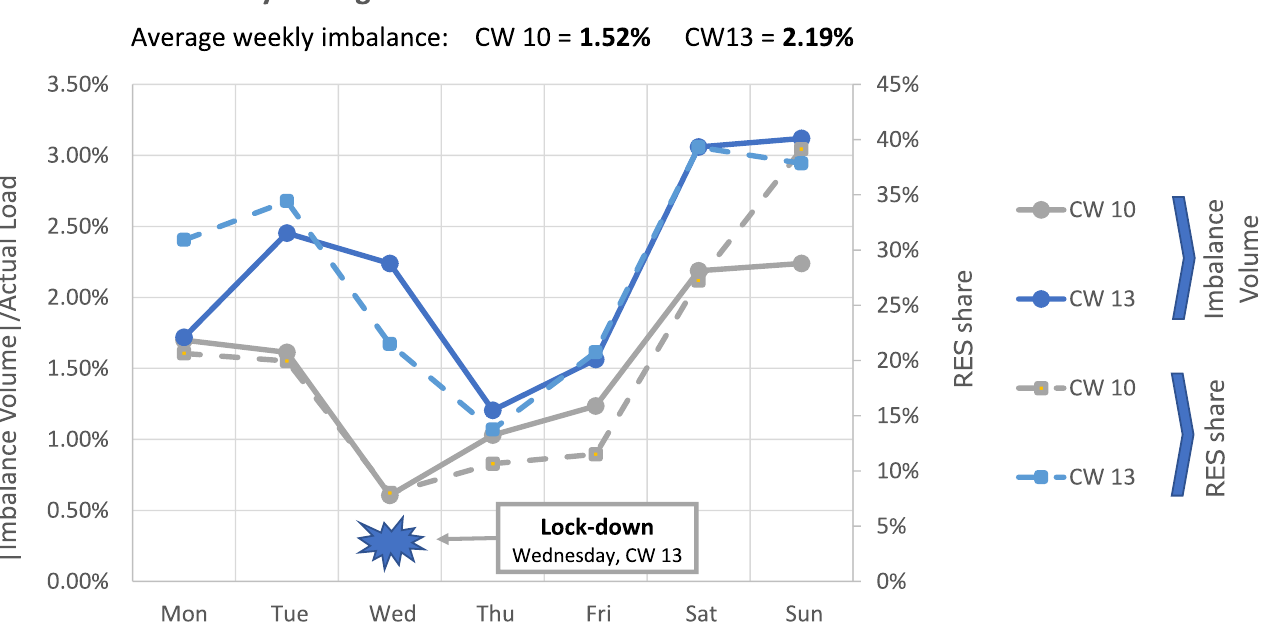
Figure 13. Daily average share of imbalance volume and share of RES for the pre- and post-lockdown week, 2nd–9th March and 22nd–28th March, respectively. There is a strong correlation between the post-lockdown RES share and imbalance